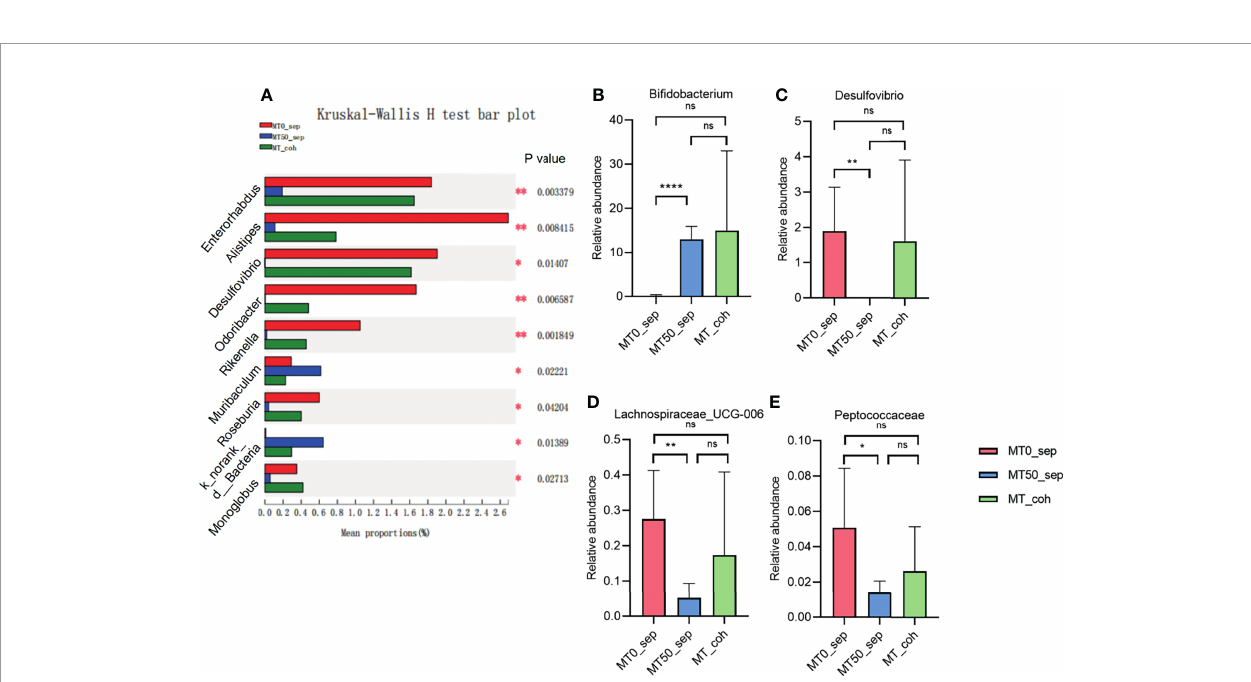
FIGURE 6 | Melatonin regulates certain microbiota on genus level. (A) Kruskal – Wallis H test for differences between separated and co-housed mice for 7-day melatonin treatment on genus levels. (B – E) Relative abundance of Bi fi dobacterium , Desulfovibrio , Lachnospiraceae_UCG-006, and Peptococcaceae on genus levels. Data are expressed as mean ± SD. * p < 0.05; ** p < 0.01; **** p < 0.0001. ns, no signi fi